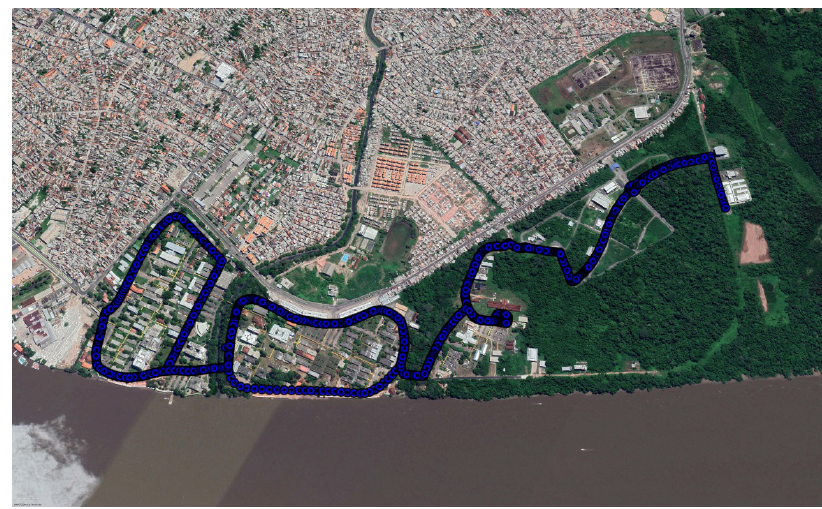
Figure 5. The route to be covered by the LoRaWAN network is represented in blue.